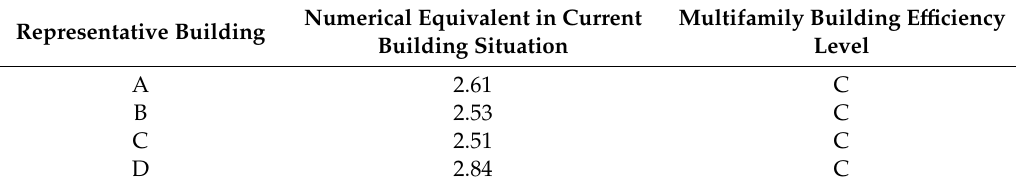
Table 9. Final classification of the representative multi-family buildings using the RTQ-R.